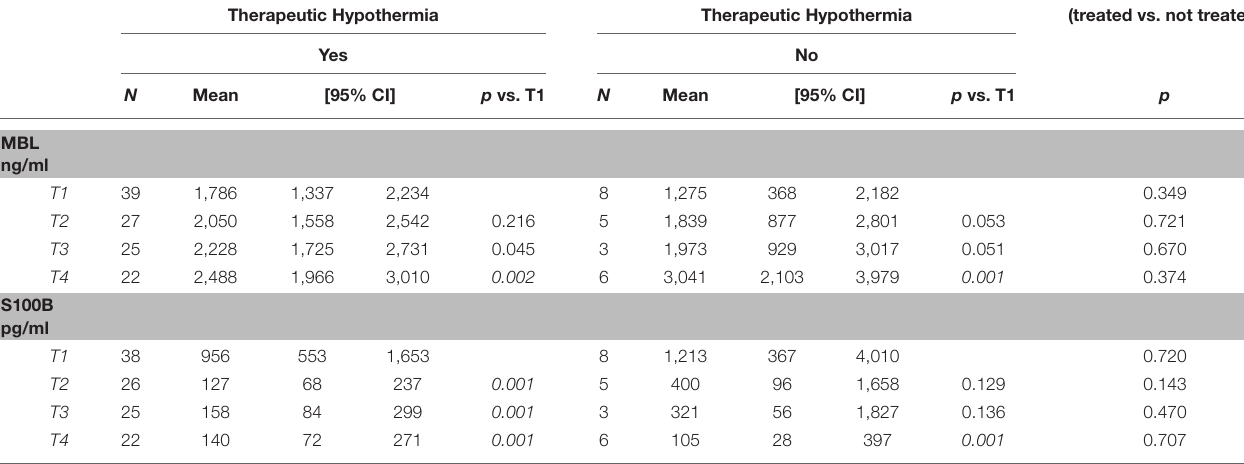
TABLE 5 | MBL and S100B mean values at different time points in the two groups of neonates. Therapeutic